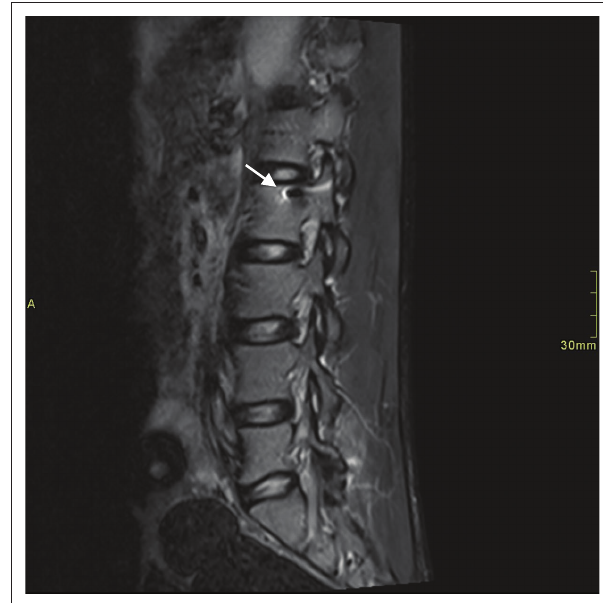
FIGURE 6: Sagital T2 short tau inversion recovery image demonstrating retained metallic foreign object in the L2 vertebral